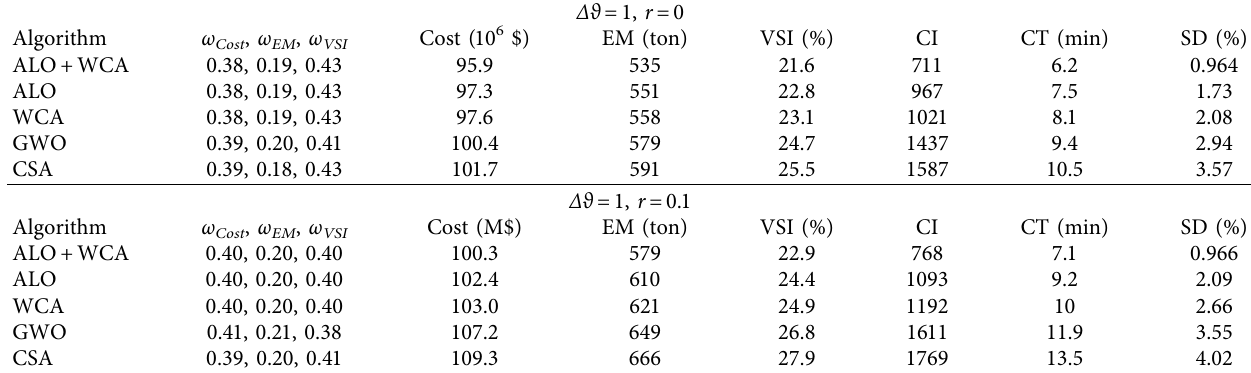
Table 3: The best compromise solution obtained by various algorithms in distinct robust